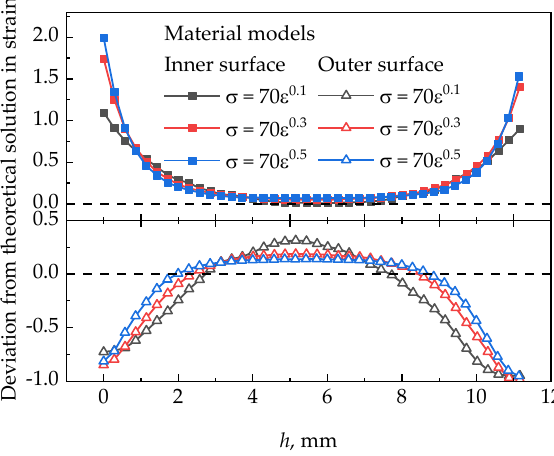
Figure 8. Deviation from theoretical solution in strain ( R D ) at the inner and the outer surfaces with different strain-hardening exponents after one rotation of t -HPS.